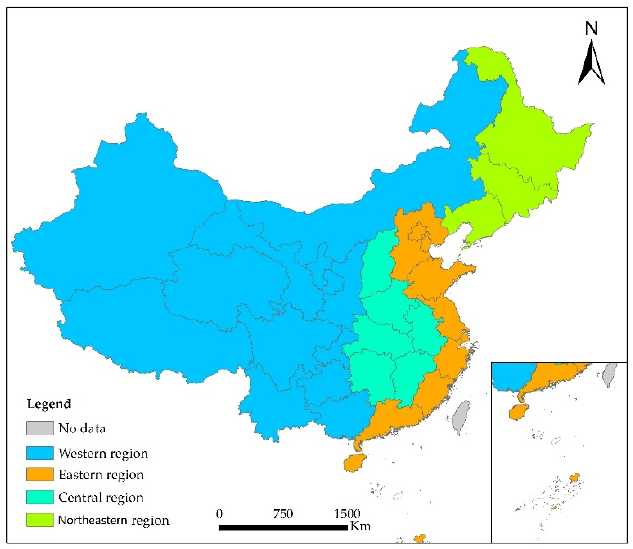
Figure 1. Data source for four regions in China.